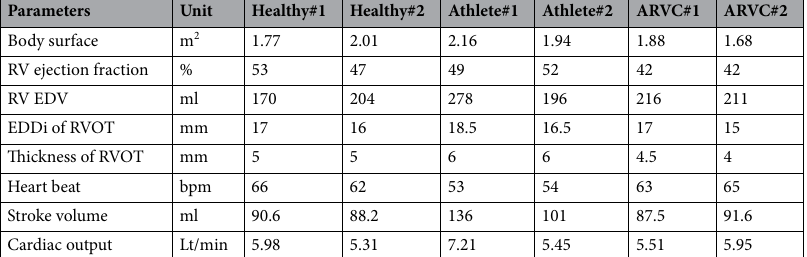
Table 2. Flow parameters obtained in vivo for all study participants. EDDi end-diastolic diameter indexed for body surface area, EDV end-diastolic volume, RV right ventricular, RVOT right ventricular outflow tract.